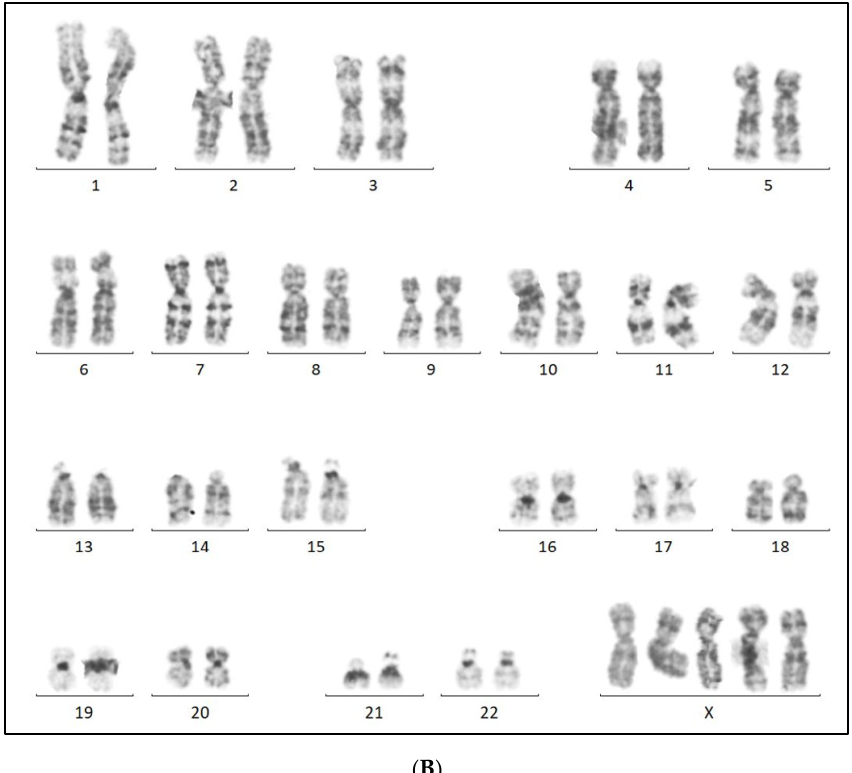
Figure 1. Cytogenetics characterization of amniotic fluid. ( A ) QF-PCR analysis. Informative STR markers on all autosomal chromosomes demonstrate a normal 1:1 marker ratio. The presence of AMELX and the absence of AMELY and SRY is consistent with female gender. The T1 and T3 markers are non-polymorphic (non-STR) X chromosome counting markers that may be used to determine the number of X chromosomes. The abnormal marker ratio (1:5) of the X chromosome counting markers (T1 and T3) is consistent with an abnormal female X chromosome dosage. Informative X chromosomal STR markers (X1, X3, X9) demonstrate abnormal marker ratios, and is consistent with the dosage of more than three X chromosomes. Informative pseudoautosomal STR markers (XY2 and XY3) demonstrate an abnormal (4:1) marker ratio; ( B ) GTG banding analysis of amniotic fluid show a 49,XXXXX karyotype.